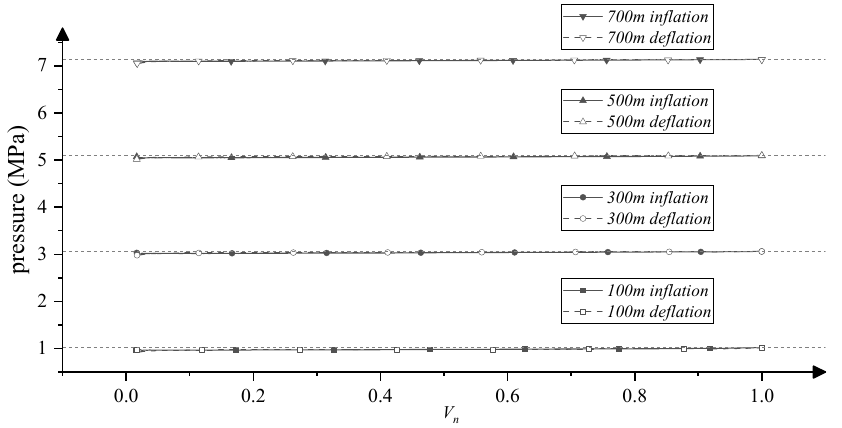
Figure 13. Relation of the air pressure and inflation ratio of a 4 m airbag at different depths.